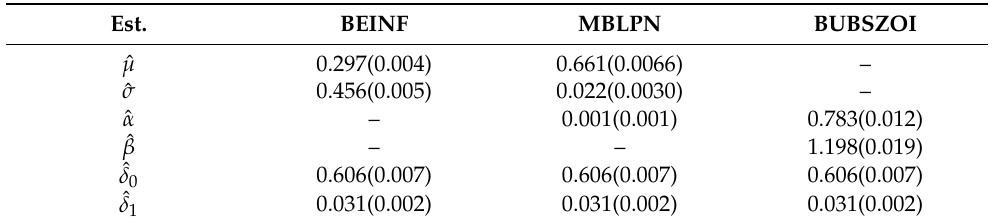
Table 2. The MLE of the parameters of the mixtures of the Bernoulli distribution with: Beta, LPN and UBS